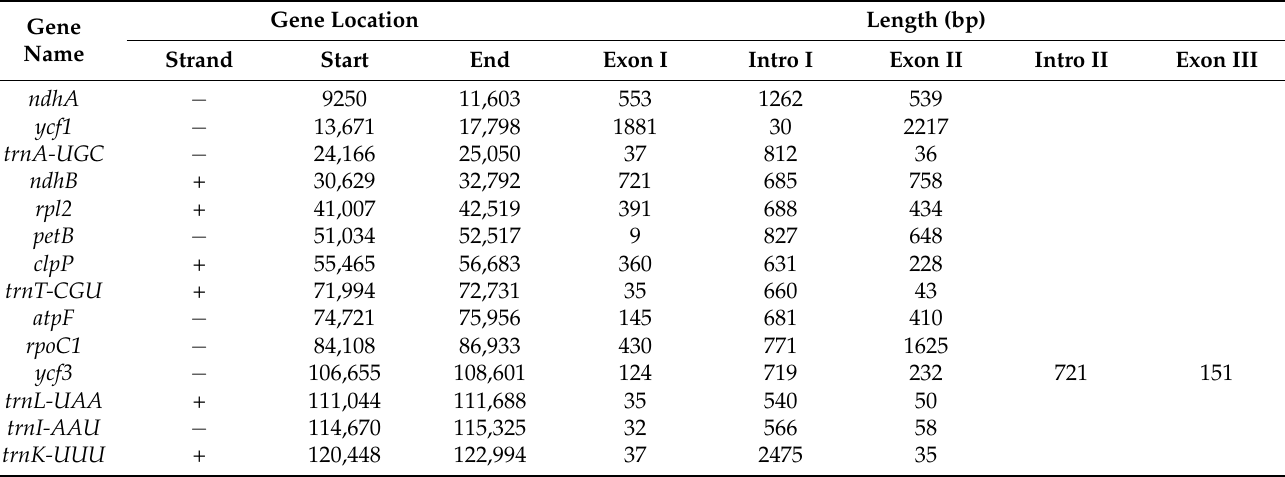
Table 1. Lengths of introns and exons of the split genes in the Galega orientalis complete chloro ‐ plast genome.